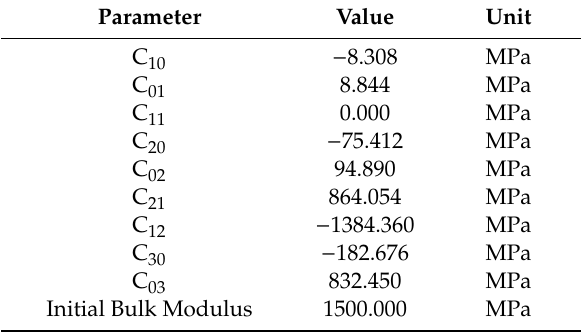
Table A1. Model parameters of the silicone rubber used in the